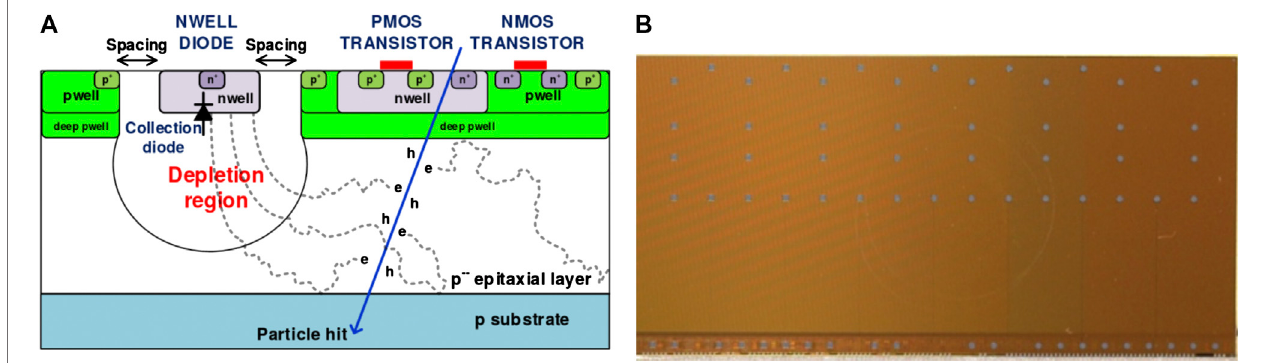
FIGURE1|(A) CrosssectionalviewofALICE pixeldetector(ALPIDE)pixelshowingthecollection diodeand theCMOScomponents.Theimagewaspublishedas Figure1inRef.68,CreativeCommonsAttribution3.0LicenseCCBY3.0. (B) PhotographoftheALPIDE.Interfacepadsusedforbondingtotheprintedcircuitboardare visible (gray